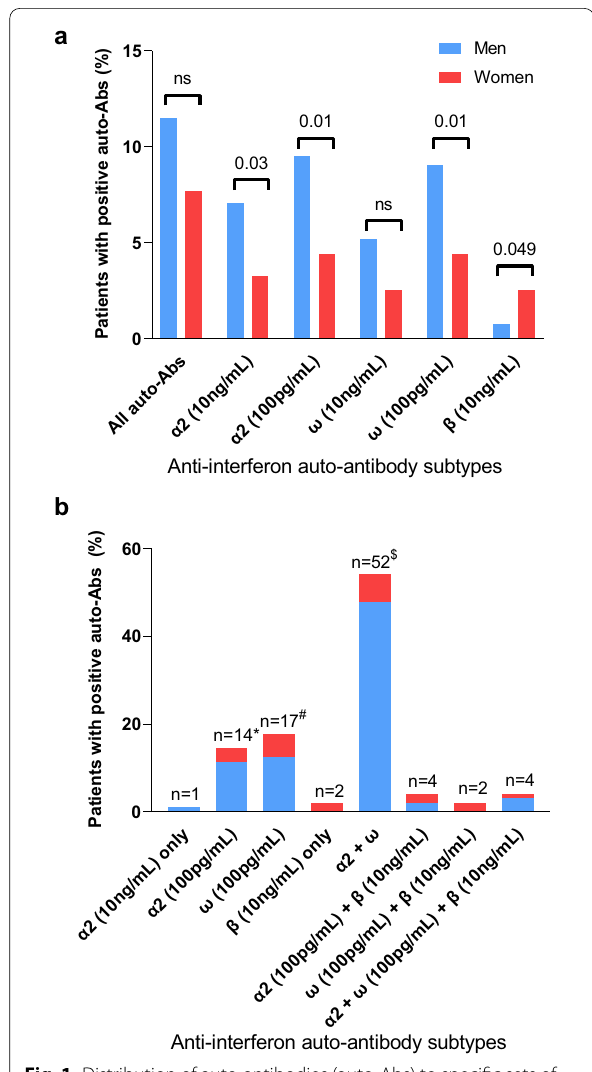
Fig. 1 Distribution of auto‑antibodies (auto‑Abs) to specific sets of type I interferons (IFNs) according to gender. a Proportion of specific sets of auto‑Abs (several patients have more than one auto‑Abs resulting in total number being greater than 96); b proportion of combinations of auto‑Abs to specific sets of type I IFNs (total numbers add‑up to 96); α 2: auto‑Abs anti‑IFN‑α2; ω : auto‑Abs anti‑IFN‑ω; β : auto‑Abs anti‑IFN‑β; *including 6 patients who also had anti‑IFN‑α2 (10 ng/mL) auto‑Abs; # including 2 patients who also had anti‑IFN‑ω (10 ng/mL) auto‑Abs; $ including 6 patients who